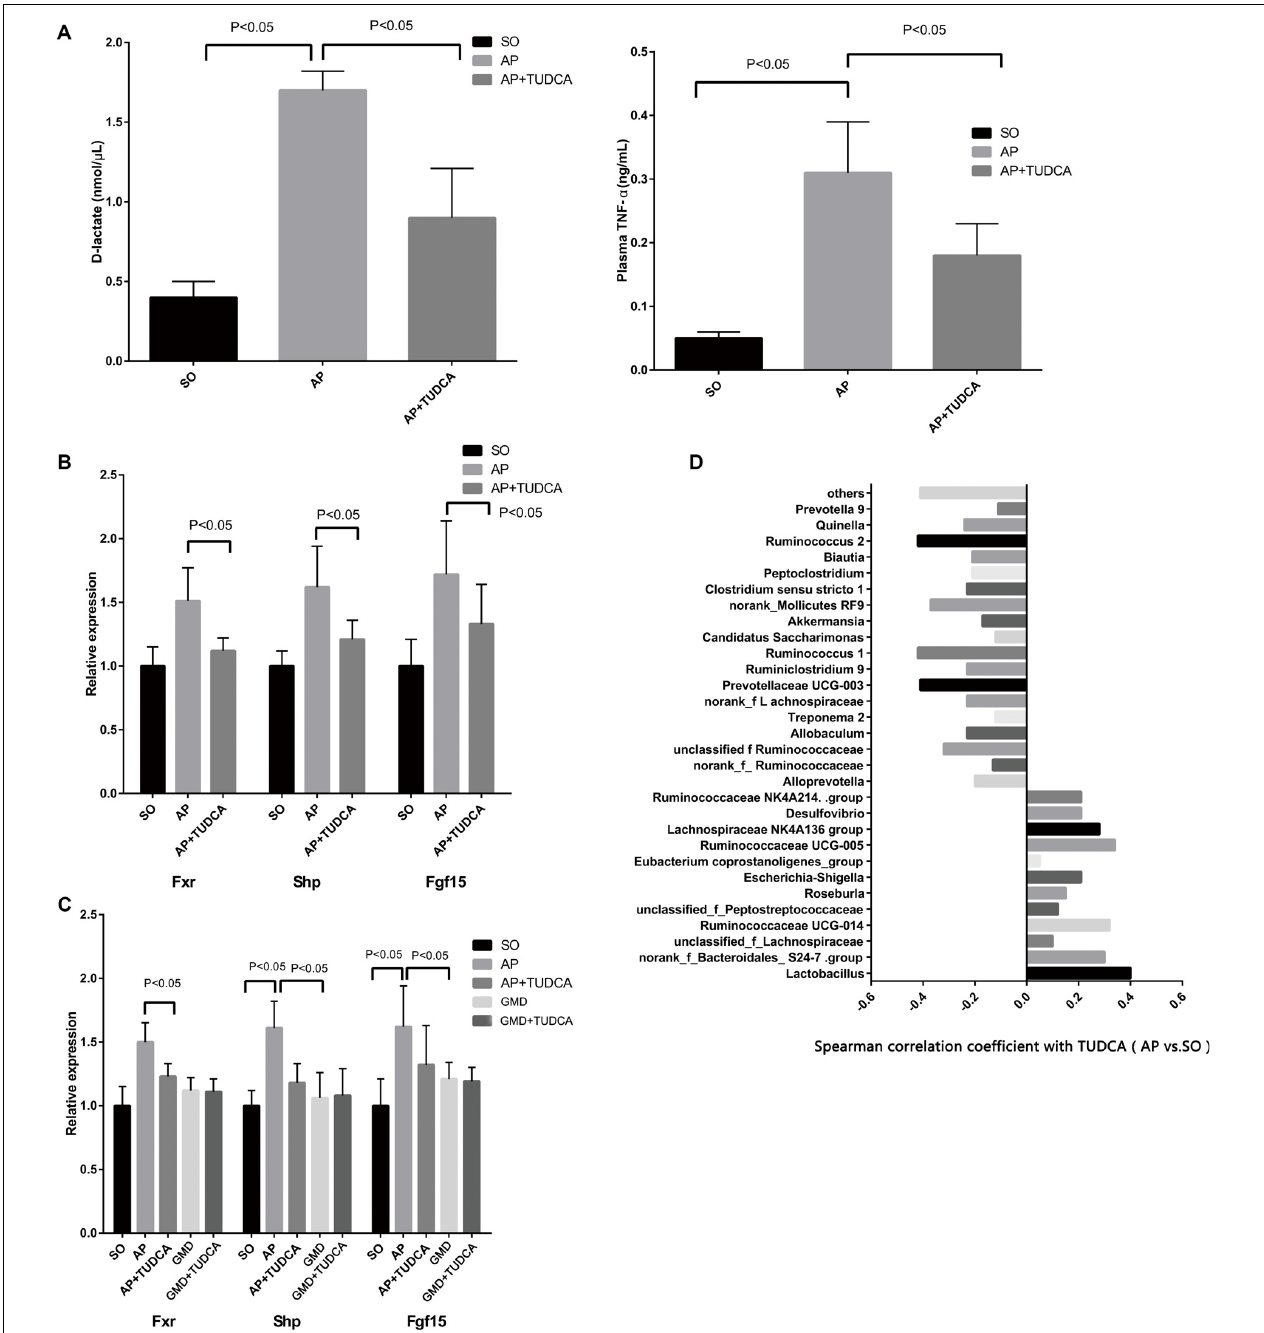
FIGURE 3 | Tauroursodeoxycholic acid (TUDCA) has therapeutic effects on acute pancreatitis associated with gut microbiota. (A) Changes of D-lactate and tumor necrosis factor α levels between the three groups. (B) Relative expression of intestinal FXR mRNA and its target gene mRNAs in mice. (C) Relative expression of intestinal Fxr, Shp, and Fgf15 mRNAs in mice. (D) Spearman correlations between the most abundant genera and